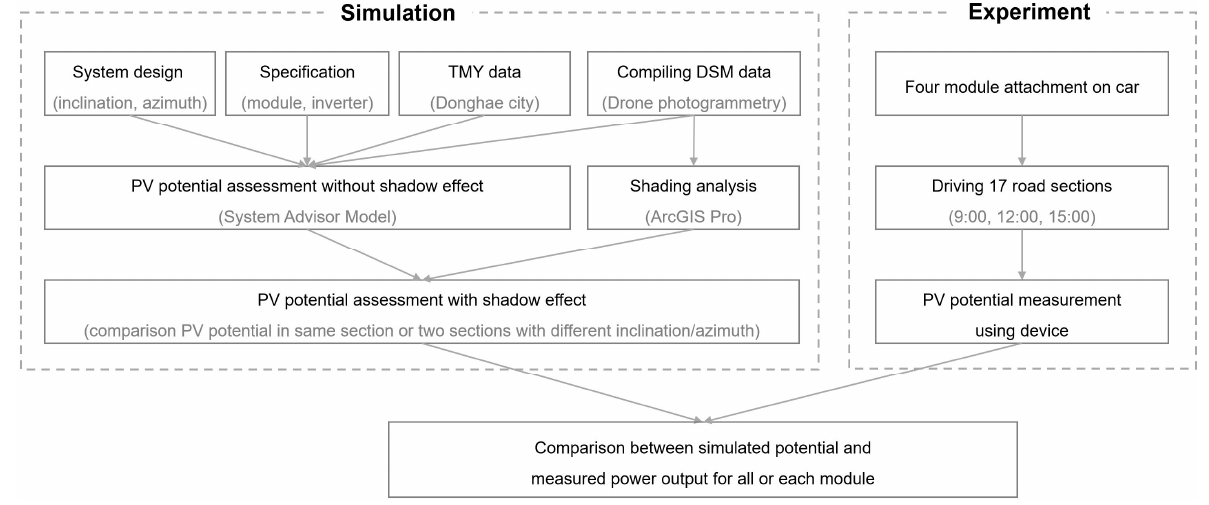
Figure 3. Flowchart for the assessment of PV potential from PV-powered EV.